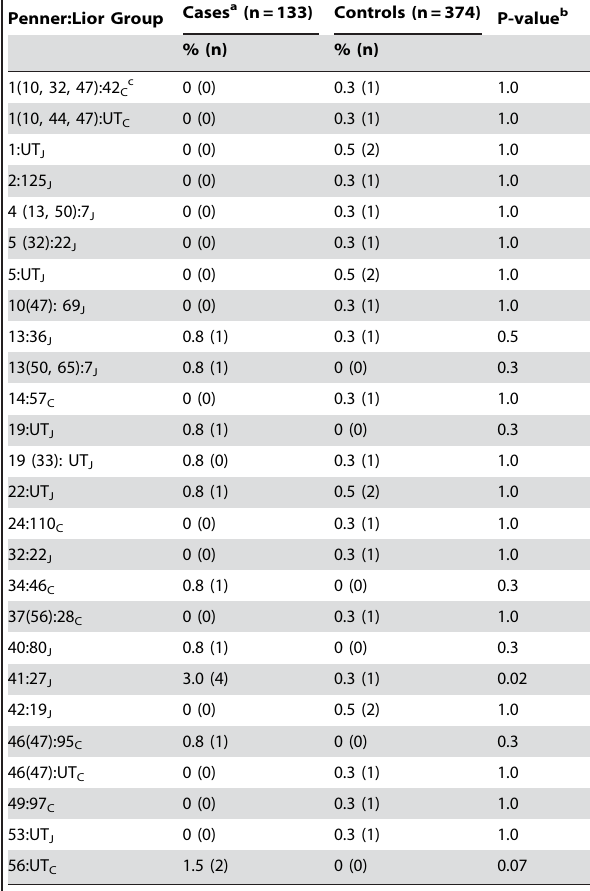
Table 2. Percent of each Penner and Lior (Penner:Lior) Campylobacter serogroup isolated from Guillain-Barre´ Syndrome cases and patient-controls, the Arab Republic of Egypt, April 2001 through September